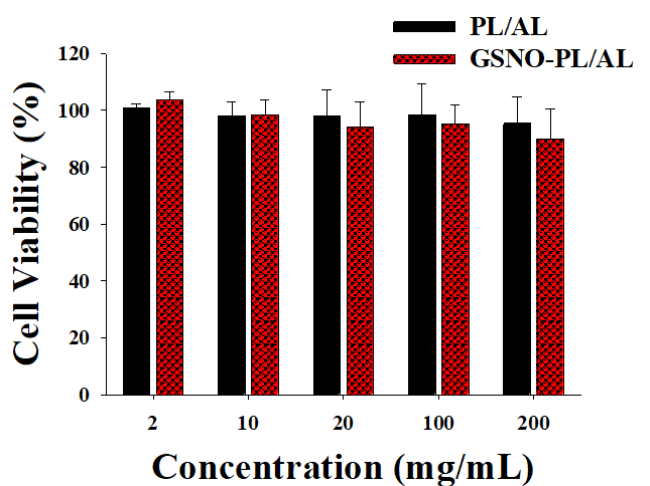
Figure 4. In vitro viability of L929 fibroblast cells after incubating for 24 h with hydrogels at various concentrations. Data shown are mean ± S.D. (n = 6).